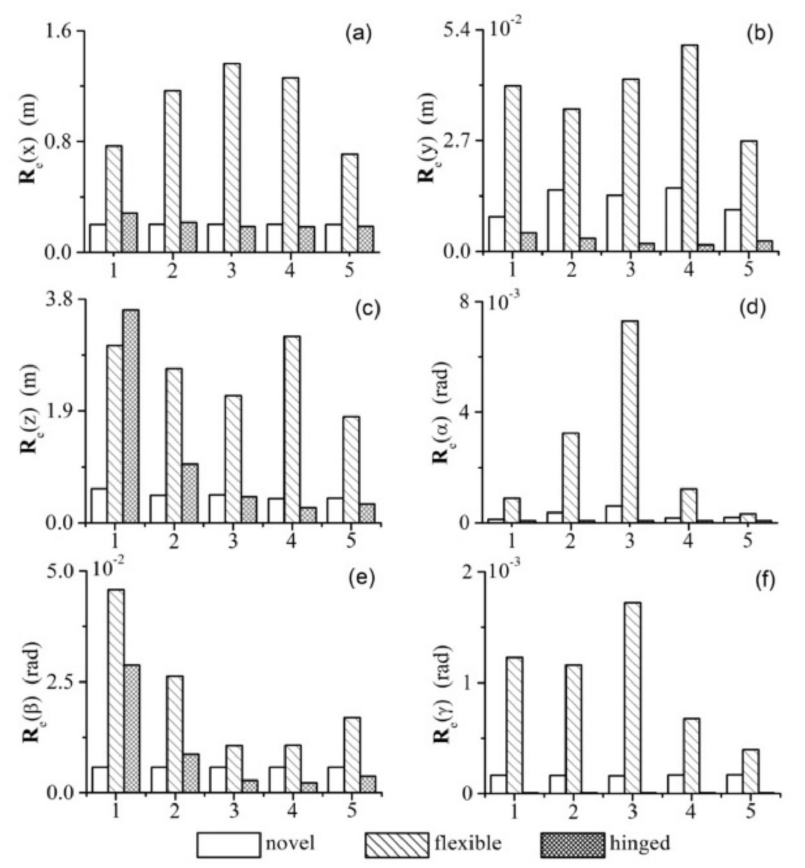
Figure 6. The amplitudes of the 1–in–1000 extreme responses of the ( a ) surge, ( b ) sway, ( c ) heave, ( d ) roll, ( e ) pitch, and ( f ) yaw motions for the wave incident angle of 0 ◦